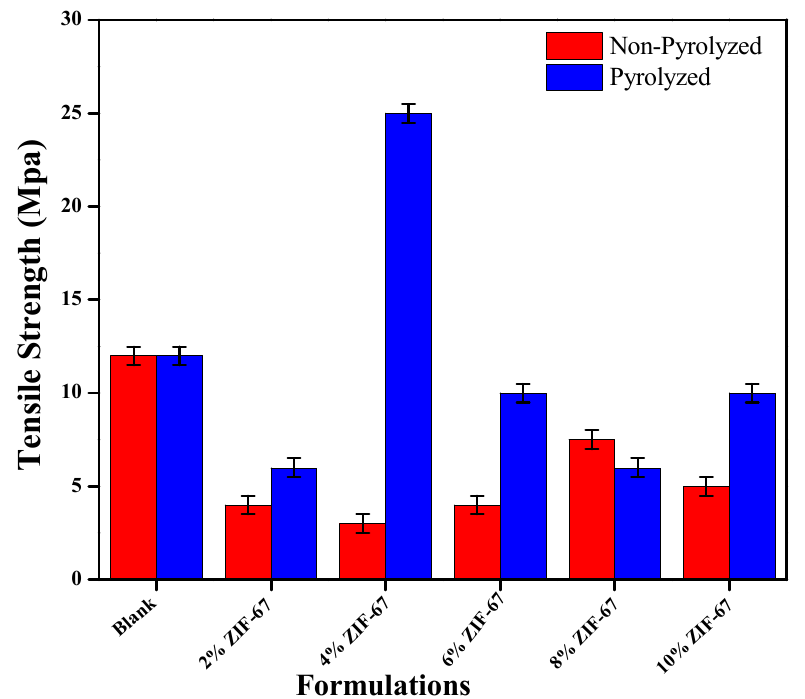
Figure 7. Tensile strength of PVA/starch nanocomposite films containing pyrolyzed ZIF-67 and non-pyrolyzed ZIF-67.